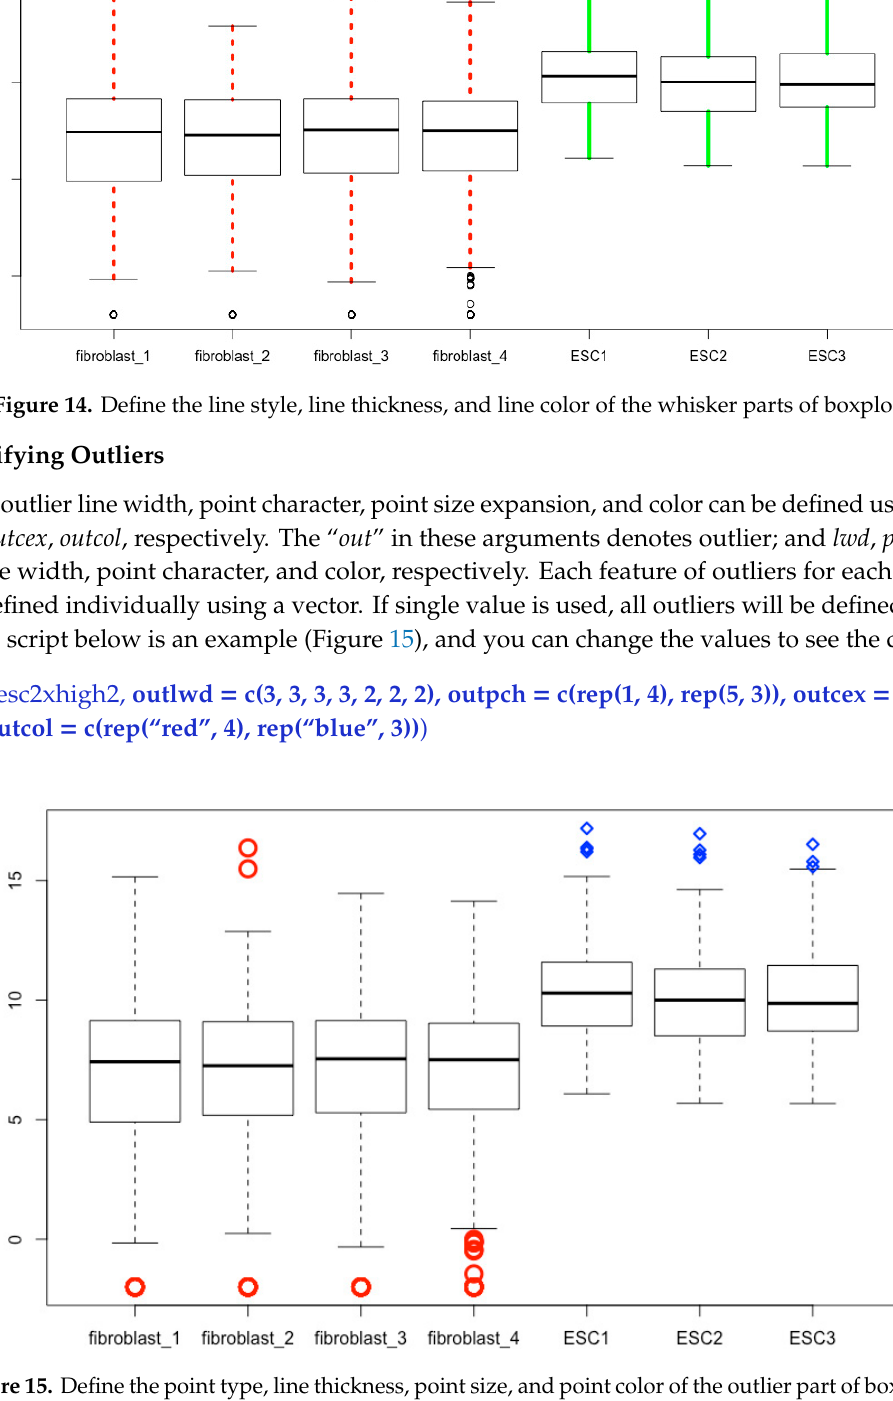
Figure 15. Define the point type, line thickness, point size, and point color of the outlier part of